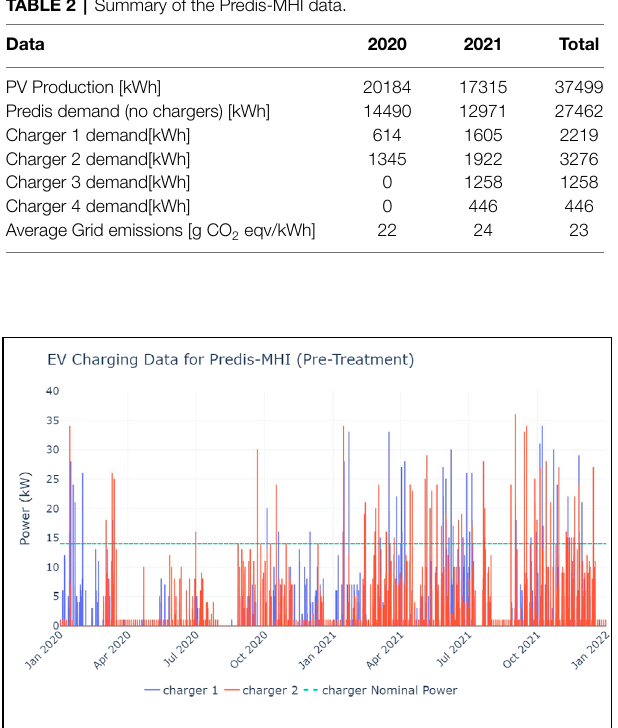
FIGURE 4 | EV charging data with errors